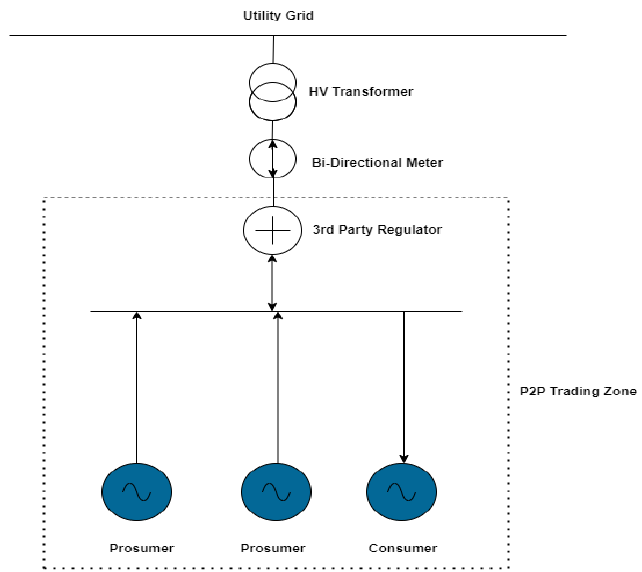
Figure 2. Single line diagram of the proposed P2P zone .